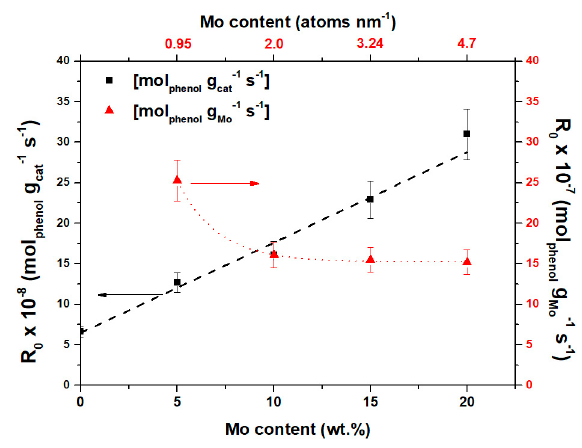
Figure 1. Normalized initial reaction rate of HDO of phenol for unpromoted Mo / AT2 catalysts at different Mo loadings at 5.5 MPa, 593 K, and 100 ppm S, ( ■ ) by gram of catalyst, ( ▲ ) by gram of Mo.